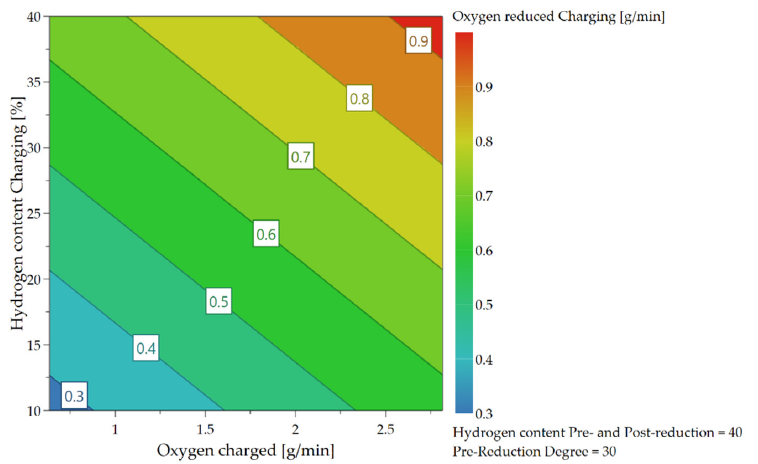
Figure 17. Average hydrogen utilization as a function of the Pre-reduction Degree.